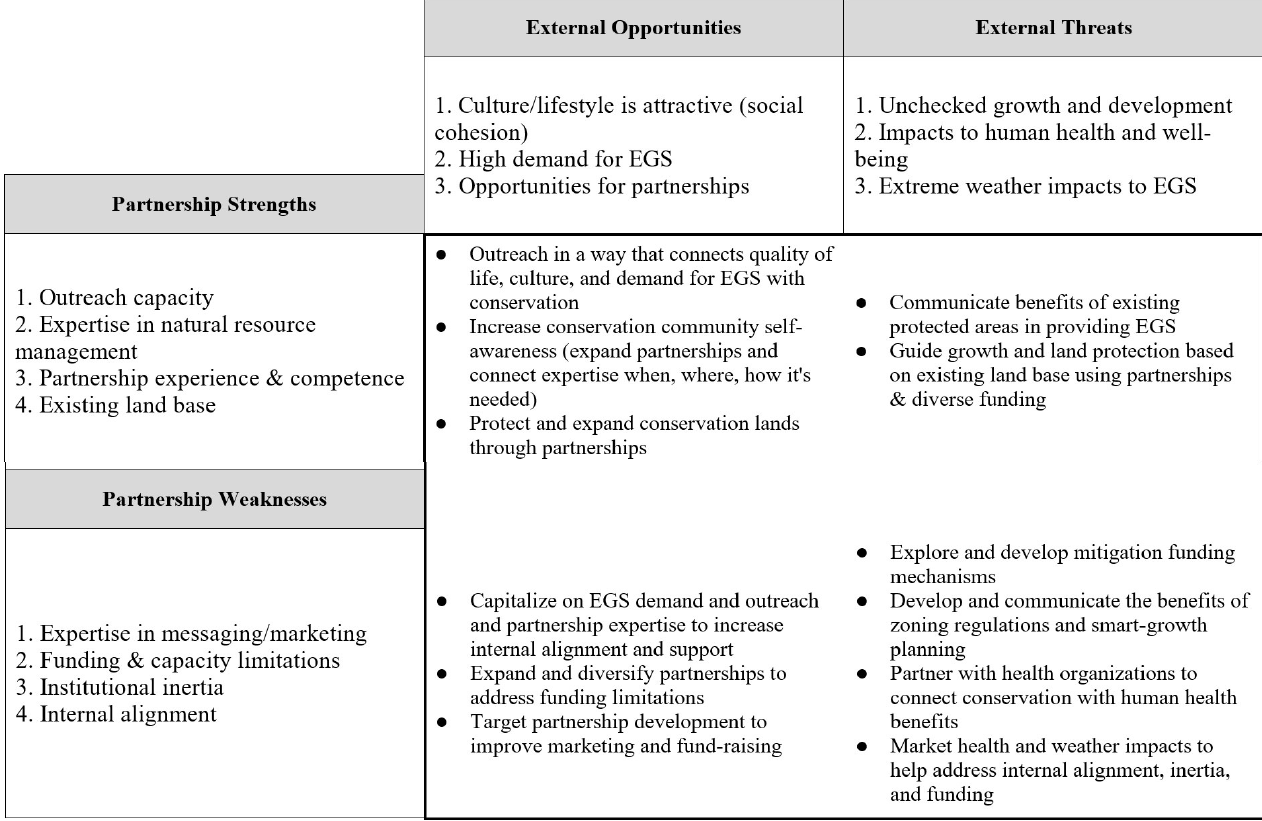
Fig. 4. Example of SWOT analysis, representing primary strengths, weaknesses, opportunities, and threats, and identifying potential strategies for the Cape Romain Partnership for Coastal Protection. Note: EGS refers to ecological goods and